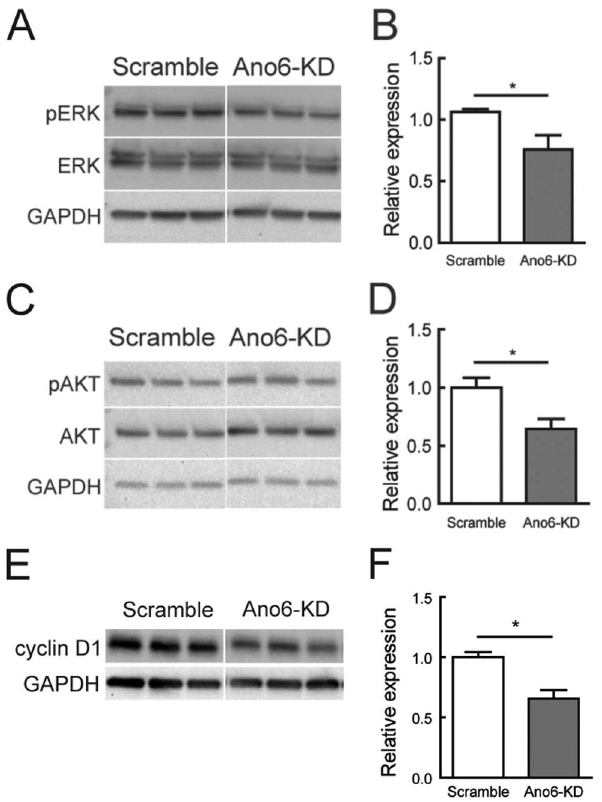
Figure 3. Altered ERK/AKT signaling in Ano6 -KD C2C12 myoblasts. (A) Western blotting analysis of ERK phosphorylation (pERK) and total ERK expression (ERK) in C2C12 myoblasts of different stable lines. Three independent experiments per cell line were loaded on the gel. (B) Normalized expression levels of ERK phosphorylation and total ERK by membrane densitometry. (C) Western blotting analysis of AKT phosphorylation (pAKT) and total AKT expression (AKT) in C2C12 myoblasts of different stable lines. Three independent experiments per cell line were loaded on the gel. (D) Normalized expression levels of AKT phosphorylation and total AKT by membrane densitometry. (E) Western blotting analysis of cyclin D1 in C2C12 myoblasts of different stable lines. (F) Normalized expression levels of cyclin D1 by membrane densitometry. Three independent experiments per cell line were loaded on the gel. GAPDH was used as a loading control. *p , 0.05.